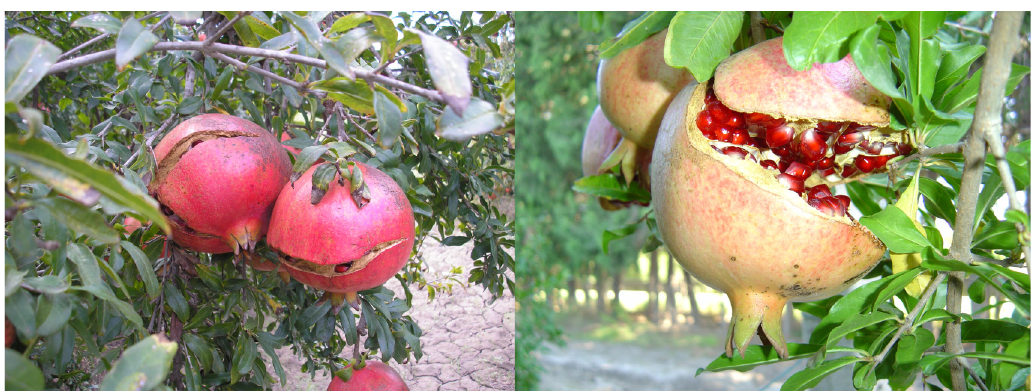
Fig. 1: Sunburn in pomegranate fruits